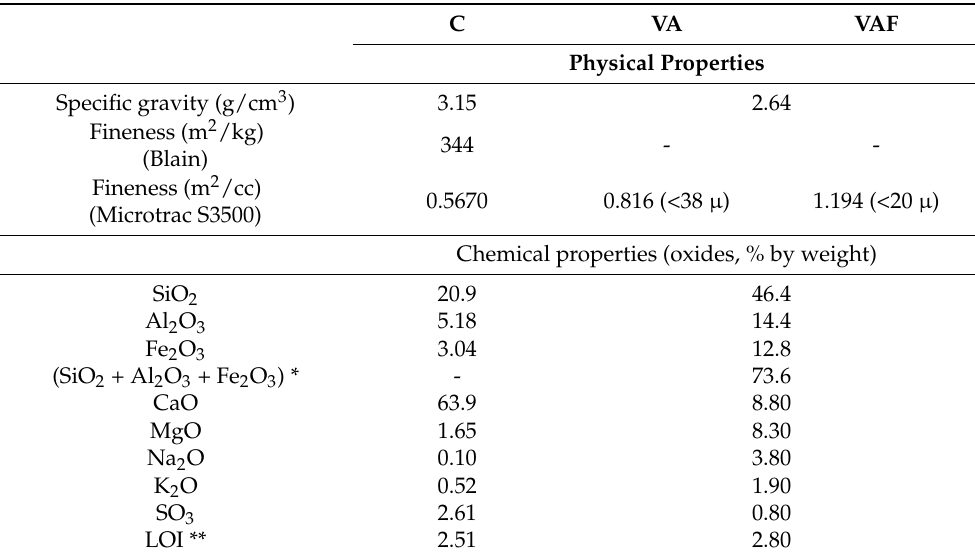
Figure 2. The materials used in this study, in powder form: cement (C); fine volcanic ash (VA); ultra- fine volcanic ash (VAF); and VA at 550 ◦ C (VA550), VA at 650 ◦ C (VA650), and VA at 750 ◦ C (VA750). Table 1. Physical and chemical composition of cement and volcanic